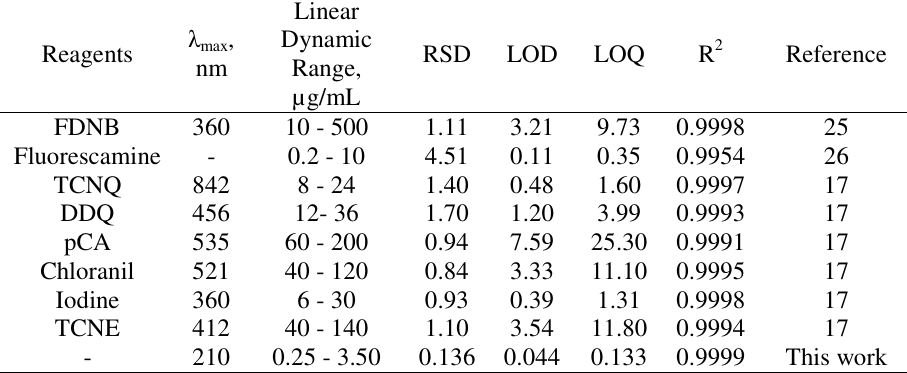
Table 6. Comparisons of the proposed method with other existing methods for the assay of gabapentin in pharmaceutical